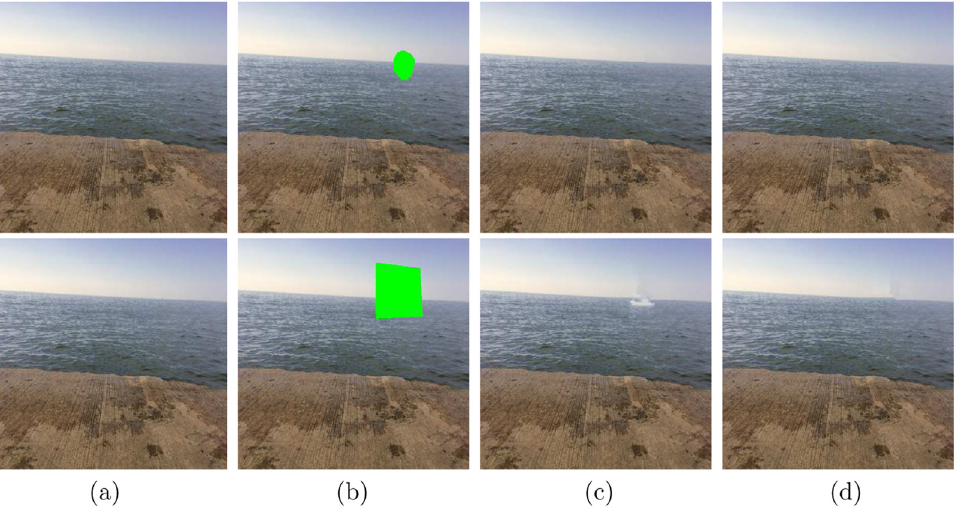
Fig 9. Test images from top to bottom: “ ErieLake ” (321 × 455) and “ ErieLake2 ” (321 × 455). (a) The original images; (b) The original images with different green target regions; (c) and (d) are the inpainted images by the method in [23] and our method, respectively. The results demonstrate that the proposed method is robust to various target regions.